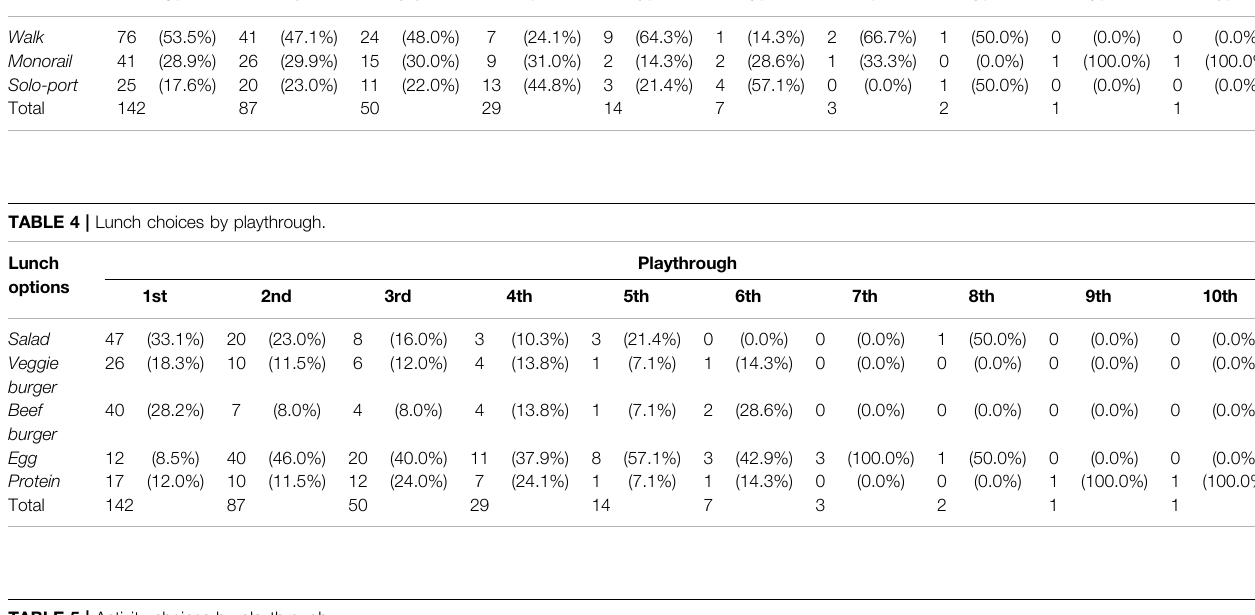
TABLE 5 | Activity choices by playthrough.